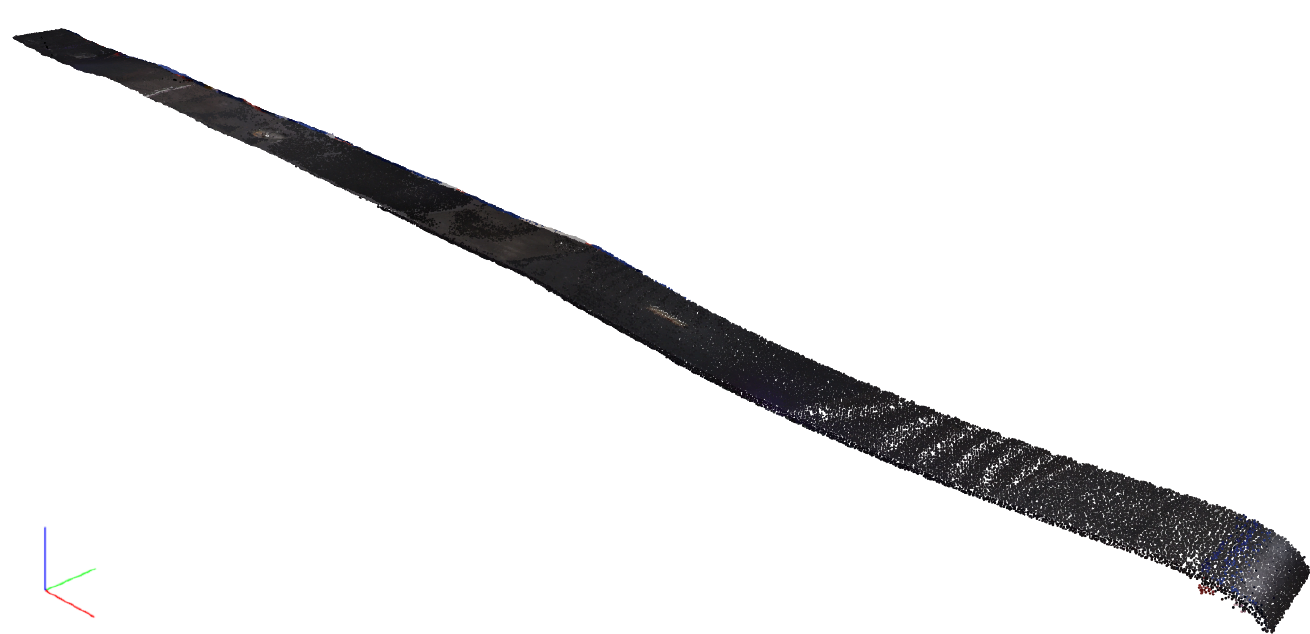
Figure 15. Final point cloud representing the belt surface.